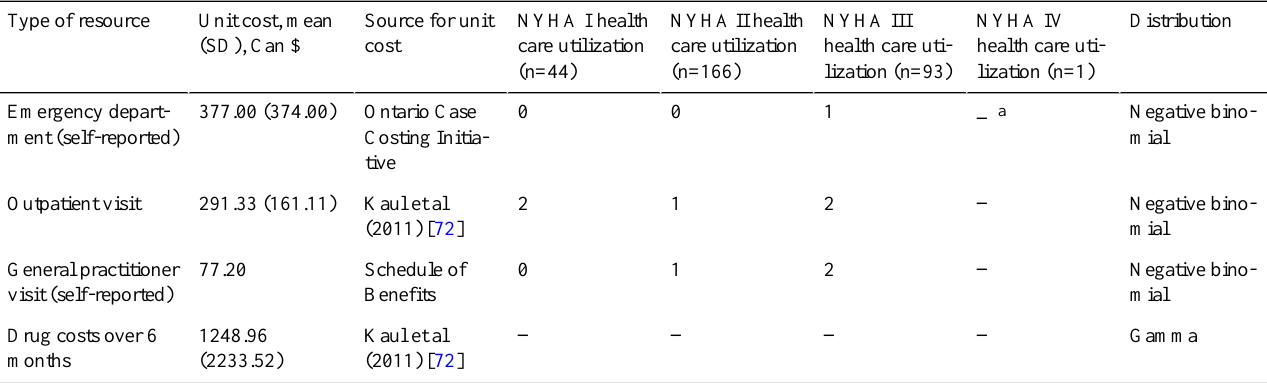
Table 3. Median health care utilization over 6 months before using Medly, unit costs per service (in Can currency), and associated distribution stratified by New York Health Association (NYHA) classes. N is the number of patients in each NYHA